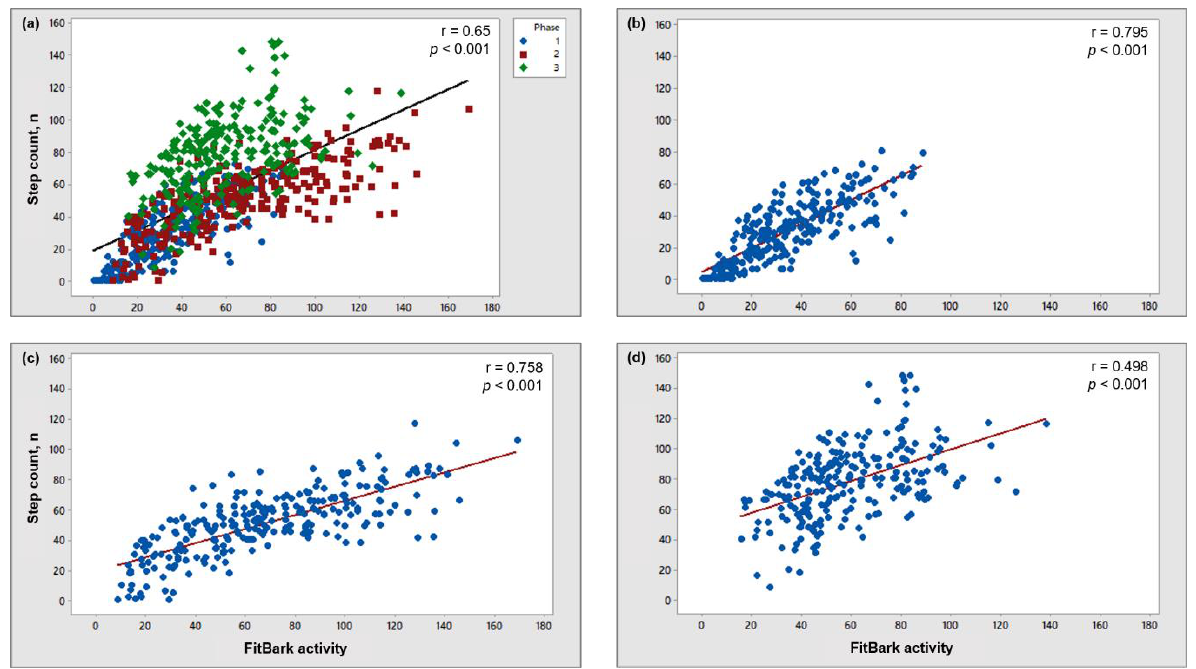
Figure 2. Plot showing the relationship between step count and activity recorded by a FitBark 2 monitor for all dogs across all phases ( a ), phase 1 (off-leash room explore; ( b )), 2 (human-dog interaction; ( c )), and 3 (on-leash walk; ( d )).